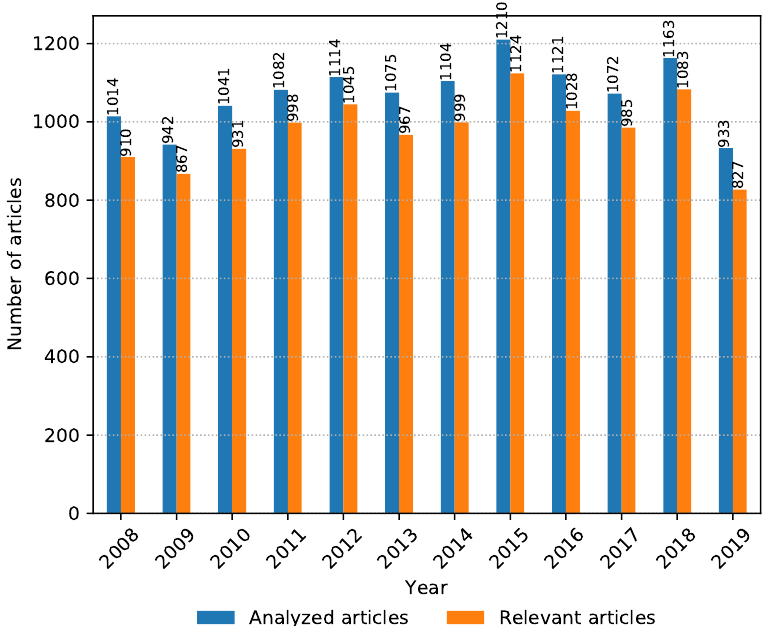
Figure 4. Number of collected and analyzed articles vs. number of relevant articles per year from 2008 to November